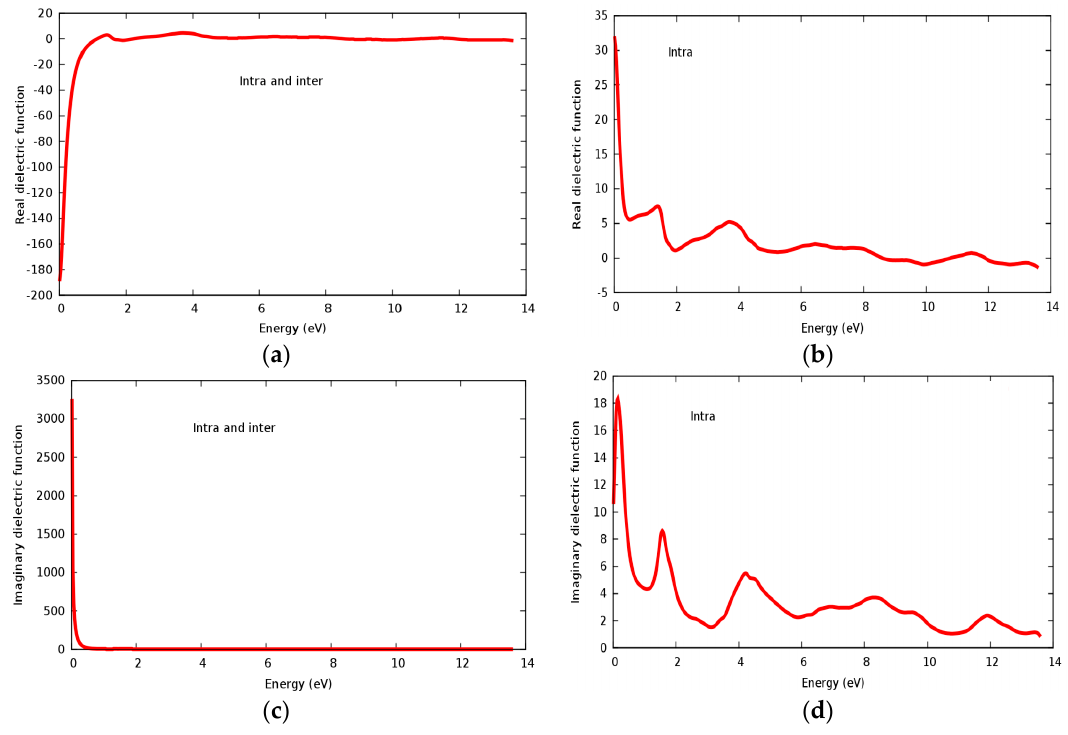
Figure 9. The dielectric function of SrRhO 3 compound: ( a , b ) Real part; ( c , d ) Imaginary part. Optical conductivity is a quantity depending on the inter band and intra band